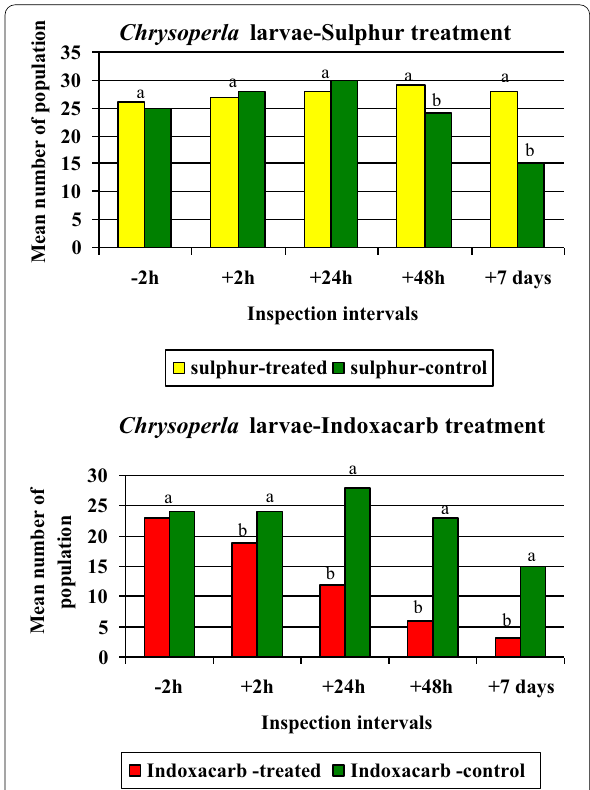
Fig. 3 Effect of indoxacarb and sorell 98% applications on the abundance of Chrysoperla larval. Significant differences were calculated separately for each interval